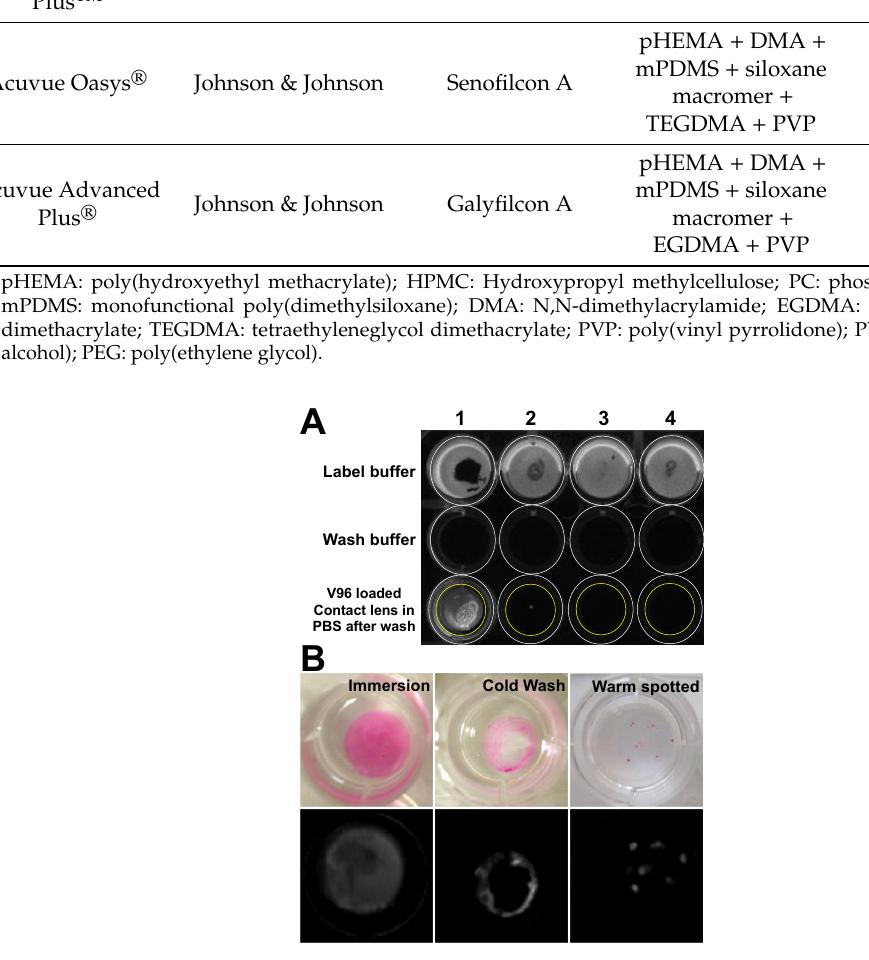
Figure 2. ELP selectively phase separate onto Proclear compatibles TM contact lens. ( A) Among four